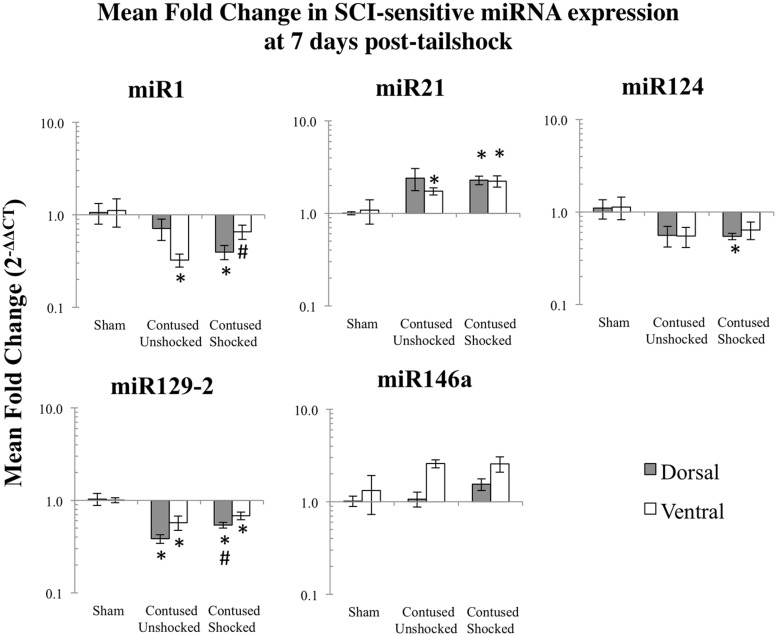
Bar graphs depicting qRT-PCR analysis of miRNA expression of miR1, miR21, miR124, miR129-2, and miR146a at the lesion site for sham animals and after unshocked or shock treatment in contused animals at 7 days following tailshock treatment. The x-axis denotes treatment condition, and the y-axis denotes the log of mean fold expression change of miRNA. Data are normalized relative to U6 small nuclear RNA internal gene expression and expressed as the mean of all fold changes of individual samples within a treatment group relative to the mean of the treatment group (+SEM), with asterisks indicating significance (LSD) compared with sham controls and hash tags indicating significance (LSD) compared with contused unshocked controls; p values are as indicated in the text.